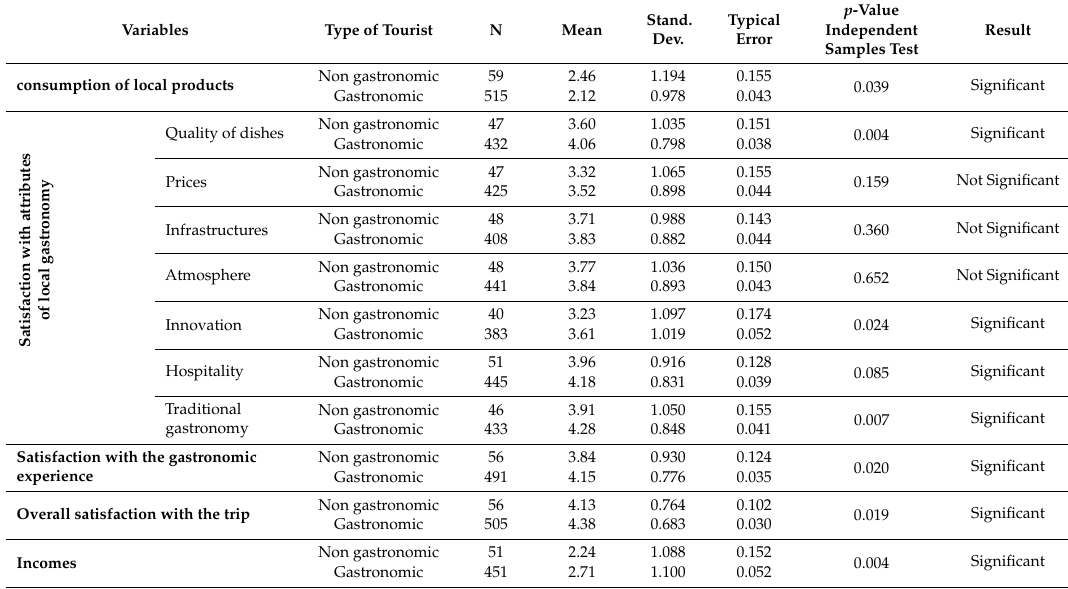
Table 8. Group statistics about the consumption of local products-gastronomic motivation to travel. Variables Type of Tourist N Mean Stand.